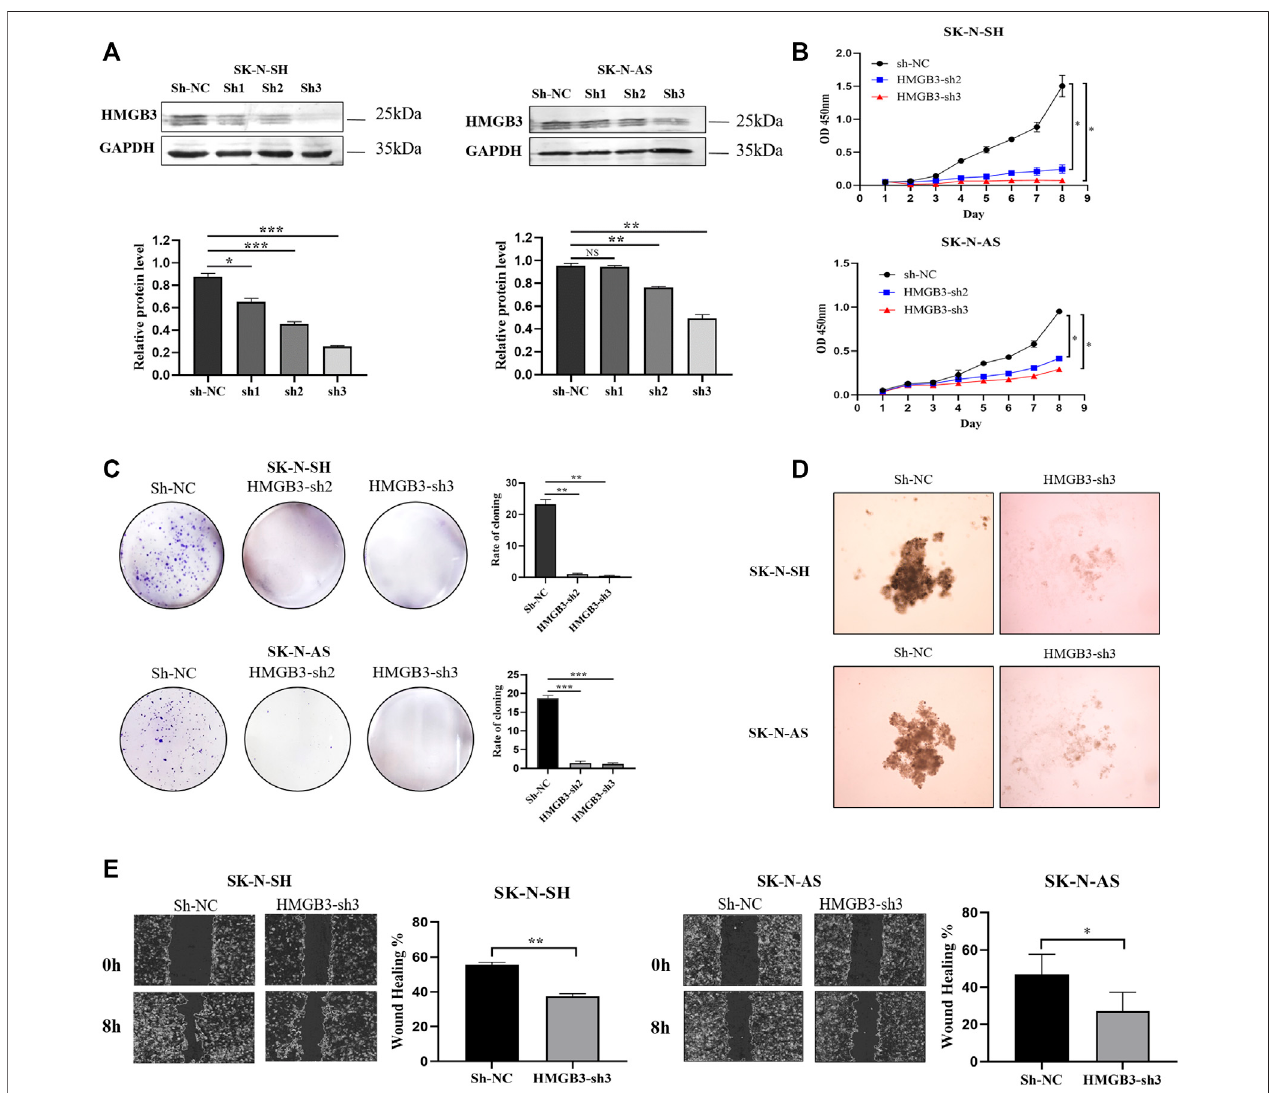
FIGURE2| KnockdownofHMGB3inhibitedcellproliferationandmigrationinNBcells invitro . (A) ProteinexpressionofHMGB3afterlentivirustransfection(sh-NC, sh-RNA1, sh-RNA2, and sh-RNA3). (B – E) CCK8, Colony formation, 3D cell culture, and wound healing assay for SK-N-SH and SK-N-AS cells with/without HMGB3 knockdown. * p < 0.05, ** p < 0.01, and *** p < 0.001.